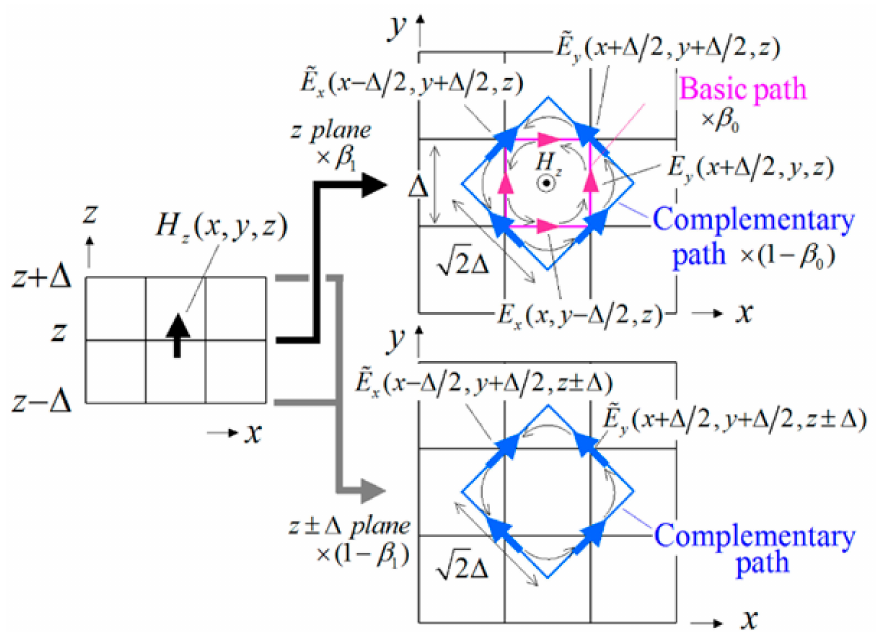
Figure 6. The four integral paths for the calculation of the H z magnetic field component on a square grid (similarly for the H x and H y fields). Specifically, we devise one basic and one complementary path at the z plane and two complementary paths at the z ± ∆ planes in order to cancel the propagation error owing to angle